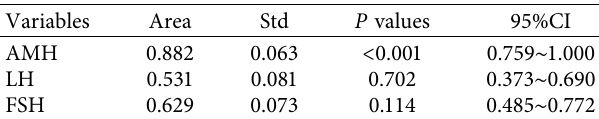
Table 4: ROC curve values for predicting spontaneous puberty in TS aged 8–17years.